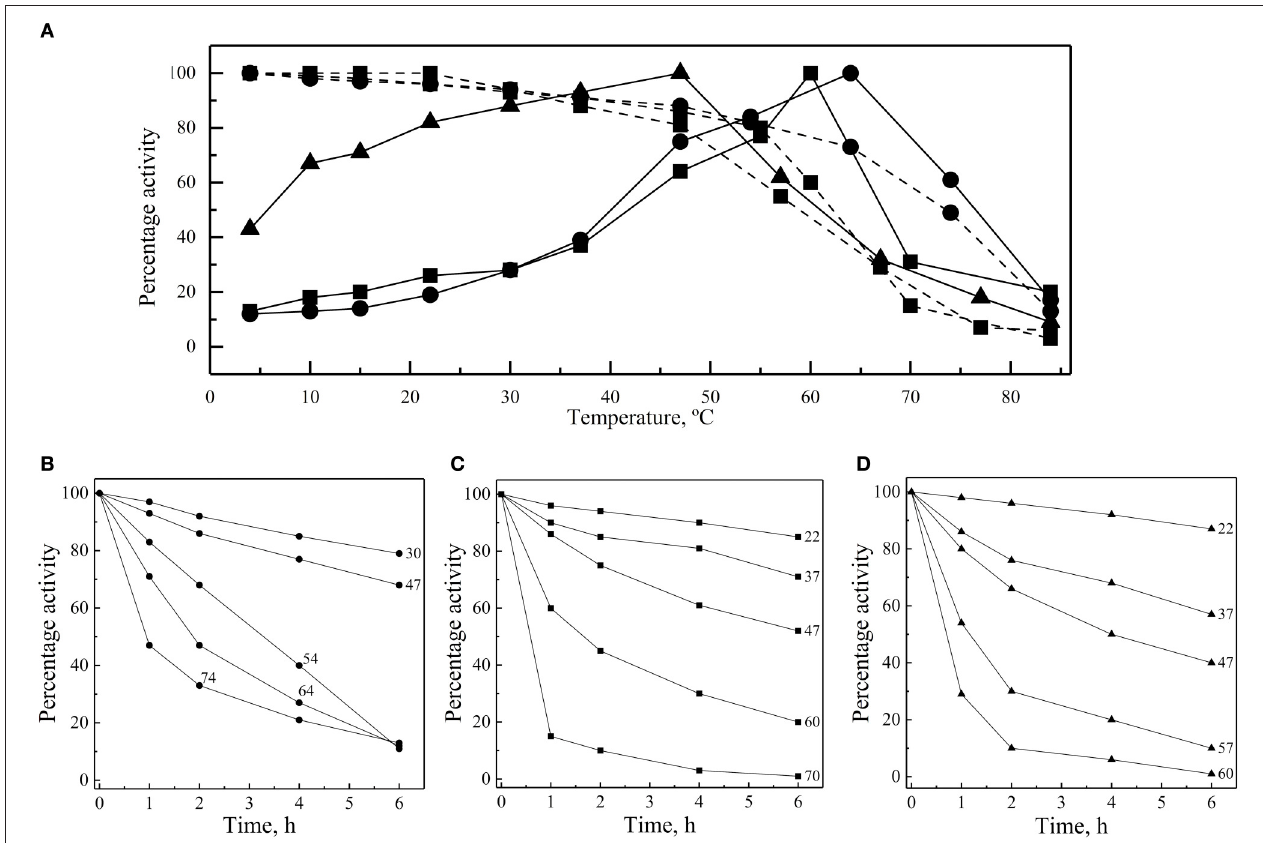
FIGURE 4 | Thermal effect on activity and stability of enzymes. (A) Enzyme activities of GOD (circles), Inv (squares) and ALP (triangles) were measured at different temperatures (continuous lines). Enzyme samples were incubated for 1h at different temperatures and then activities were determined at 64 ◦ C, 60 ◦ C, and 47 ◦ C for GOD, Inv and ALP, respectively (discontinuous lines). Activity was also measured after incubation at different temperatures for different times, and the relative enzyme activity, compared with the maximum activity reached in each case, is shown for GOD (B) , Inv (C) , and ALP (D) . The total amount of enzyme used in each assay was 15, 39, or 39 ug of GOD, Inv or ALP, respectively; the substrate concentration used was 280, 100, or 5mM of glucose, sucrose or pNPP, respectively. The Inv and ALP activity assays were performed at pH 5.0 and pH 9.0, respectively, and GOD activity determination was made in presence of 2M CaCl 2